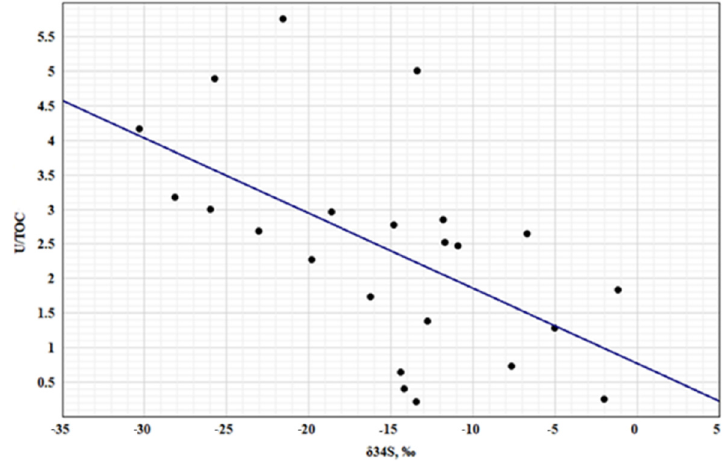
Figure 7. Cross ‐ plot of U/TOC and sulfur isotopic composition for well 1, Bazhenov Formation. Blue line corresponds to equation U/TOC = − 0.11 ∙δ 34 S + 0.77, where the correlation coefficient R = 0.57.